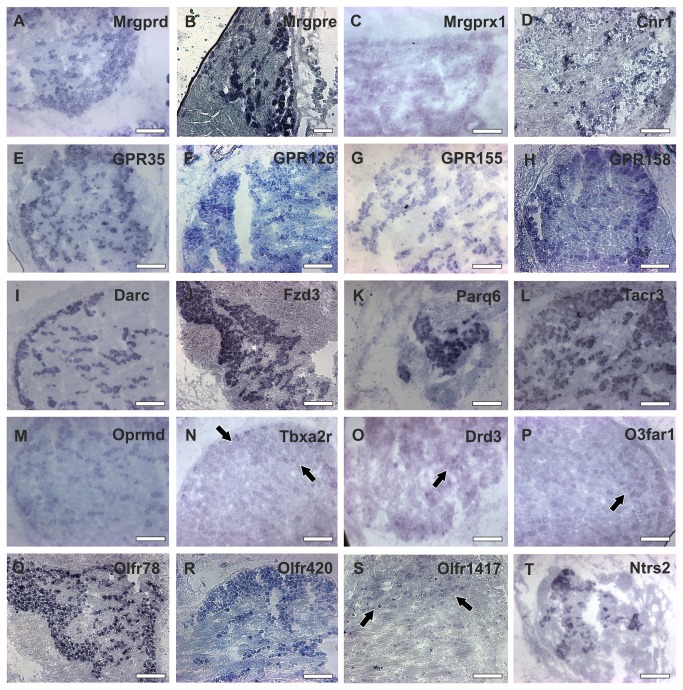

In
situ hybridization experiments in the mouse TG.
A Mrgprd (Mas-related Receptor D) B Mrgpre (Mas-Related Receptor E), C Mrgprx1 (Mas-Related Receptor X1) D Cnr (Cannabinoid Receptor 1) E Gpr35 (G-Protein Coupled Receptor 35) F Gpr126 (G-Protein Coupled Receptor 126) G Gpr155 (G-Protein Coupled Receptor 155) H Gpr158 (G-Protein Coupled Receptor 158) I Darc (Duffy/Antigen/Chemokine Receptor) J: Fzd3 (Frizzled 3) K Paqr (Progestin and AdipoQ Receptors) L Tac3 (Tachykainin 3) M Oprmd (mu-Opioid Receptor) N Tbx2 (Thromboxane A2 Receptor) O Drd3 (Dopamin Receptor D3) P O3far1 (Omega 3 Fatty Acid Receptor) Q Olfr78 (Olfactory Receptor 78/PSGR) R Olfr420 (Olfactory Receptor 420) S Olfr1417 (Olfactory Receptor 1417) T Ntrs2 (Neurotensin Receptor 2) (Scale for A, C-T 200 µm, B 100 µm).